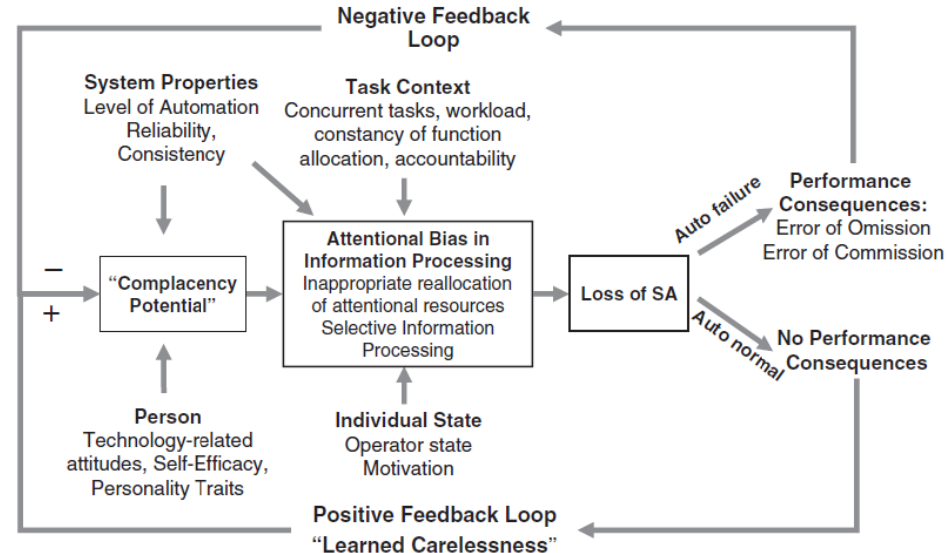
Figure 1. The integrated model of complacency and automation bias [11] (p. 404). Copyright © 2010 by Human Factors and Ergonomics Society. Reprinted by Permission of SAGE Publications, Inc., Thousand Oaks, CA, United States.